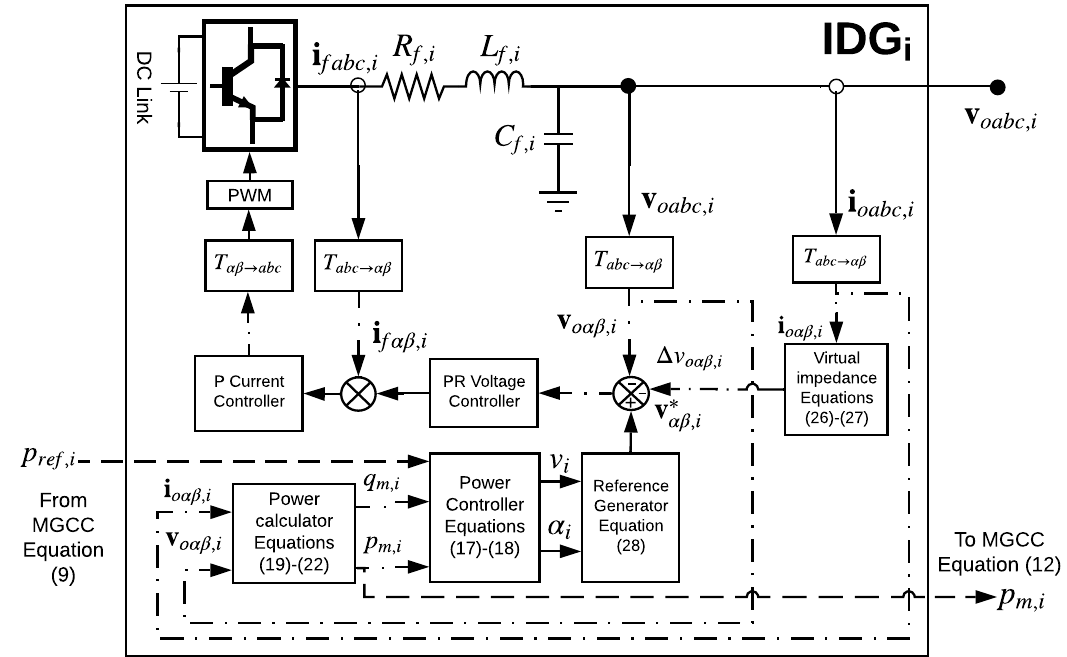
Figure 4. Inverter-based Distributed Generator